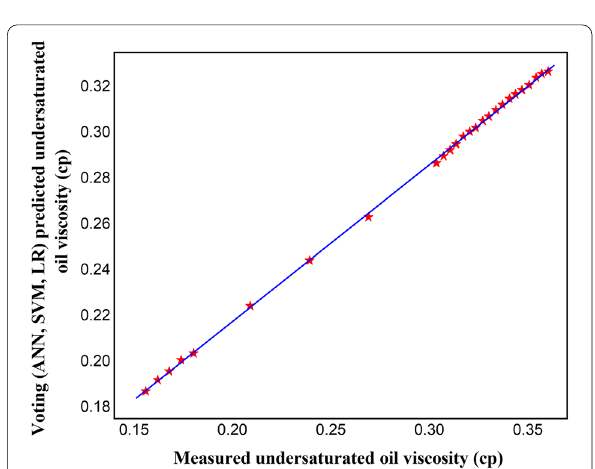
Fig. 24 Cross plot of voting (ANN, SVM, LR) predicted values versus measured values